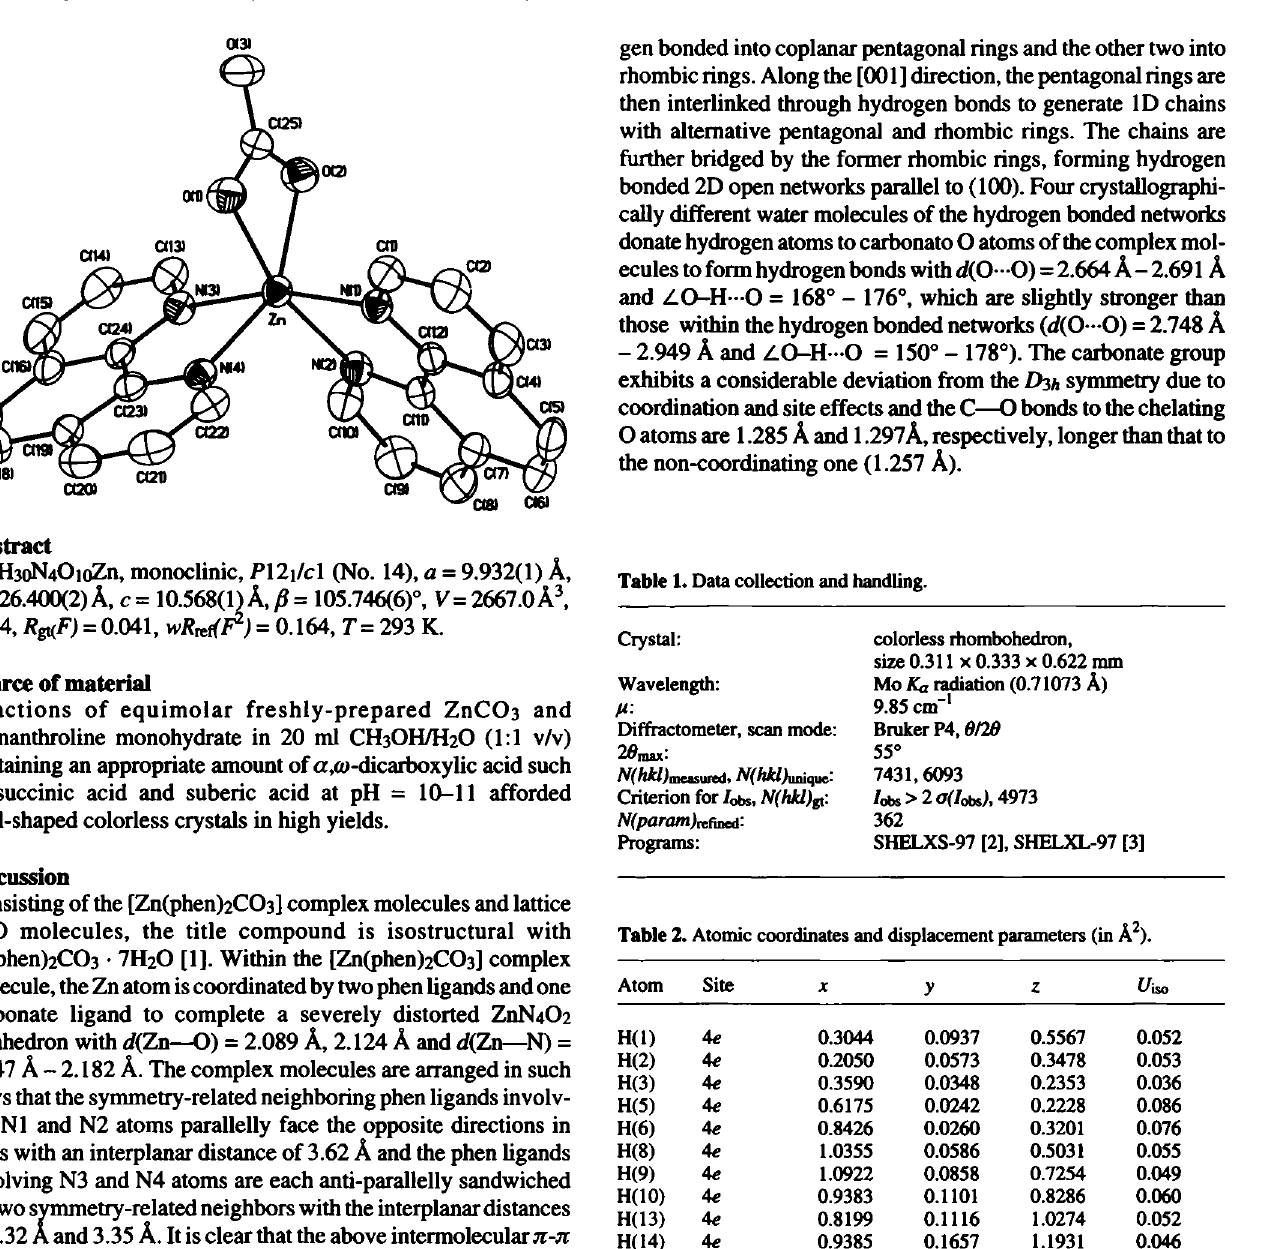
Table 2. Atomic coordinates and displacement parameters (in Â 2